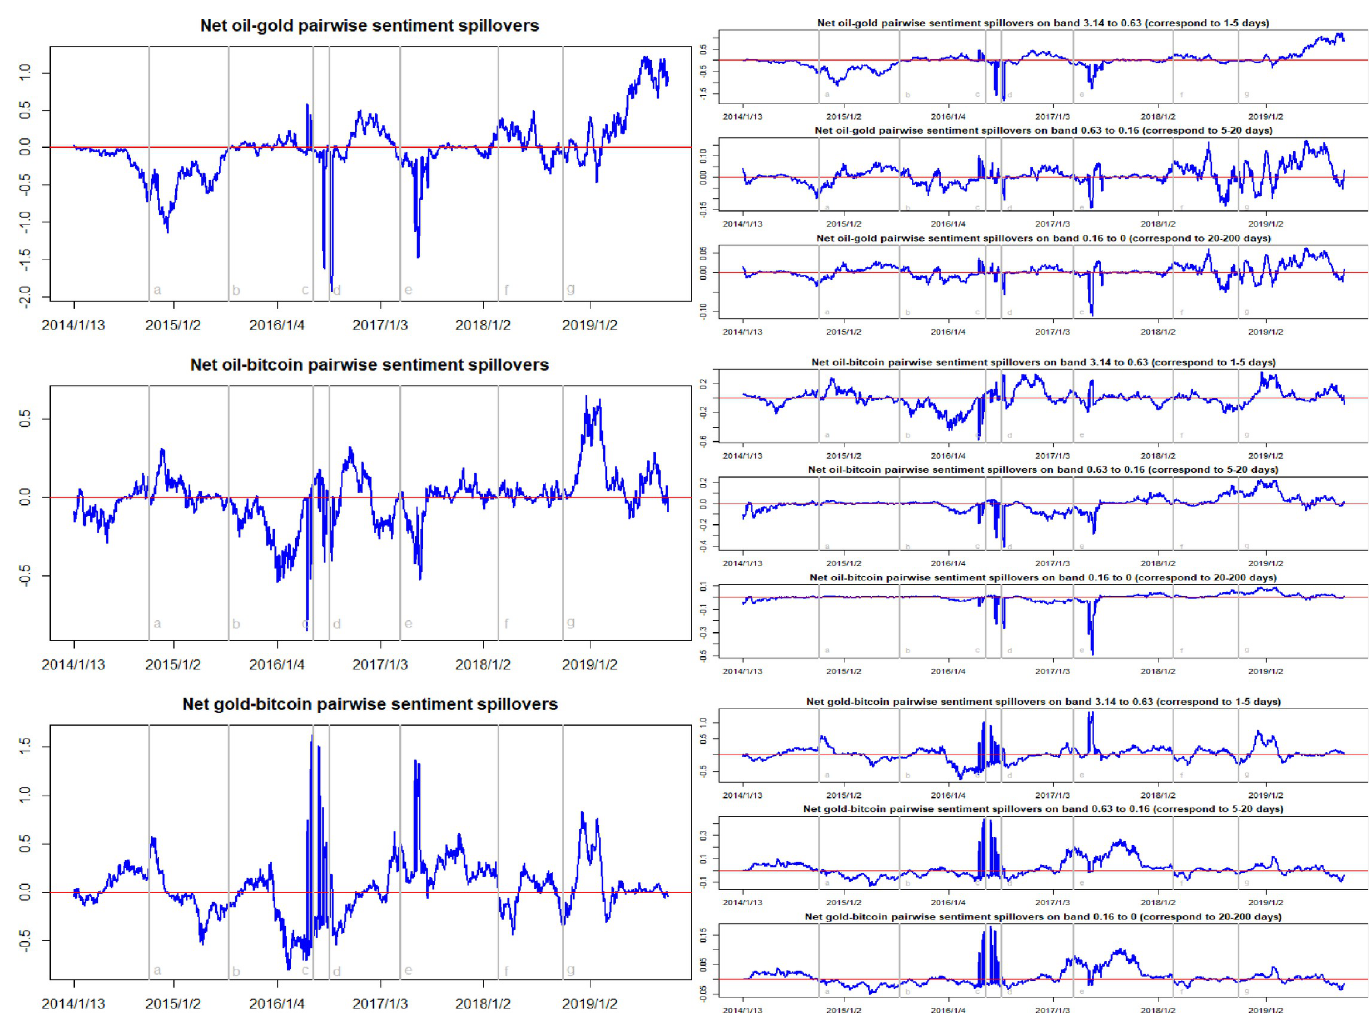
Fig 4. Time-frequency dynamics of net pairwise sentiment spillovers among oil, gold, and Bitcoin. a, b, c, d, e, f, g respectively represent the seven events: the WTI oil price collapsed in October 2014, the black swan event in gold market occurred in July 2015, the sharp rise of bitcoin prices in May 2016, the Brexit event in July 2016, the expectations of a Federal Reserve rate hike in March 2017, the price of Bitcoin and gold fluctuating fall at the beginning of 2018, and the WTI oil price declines in August 2018.